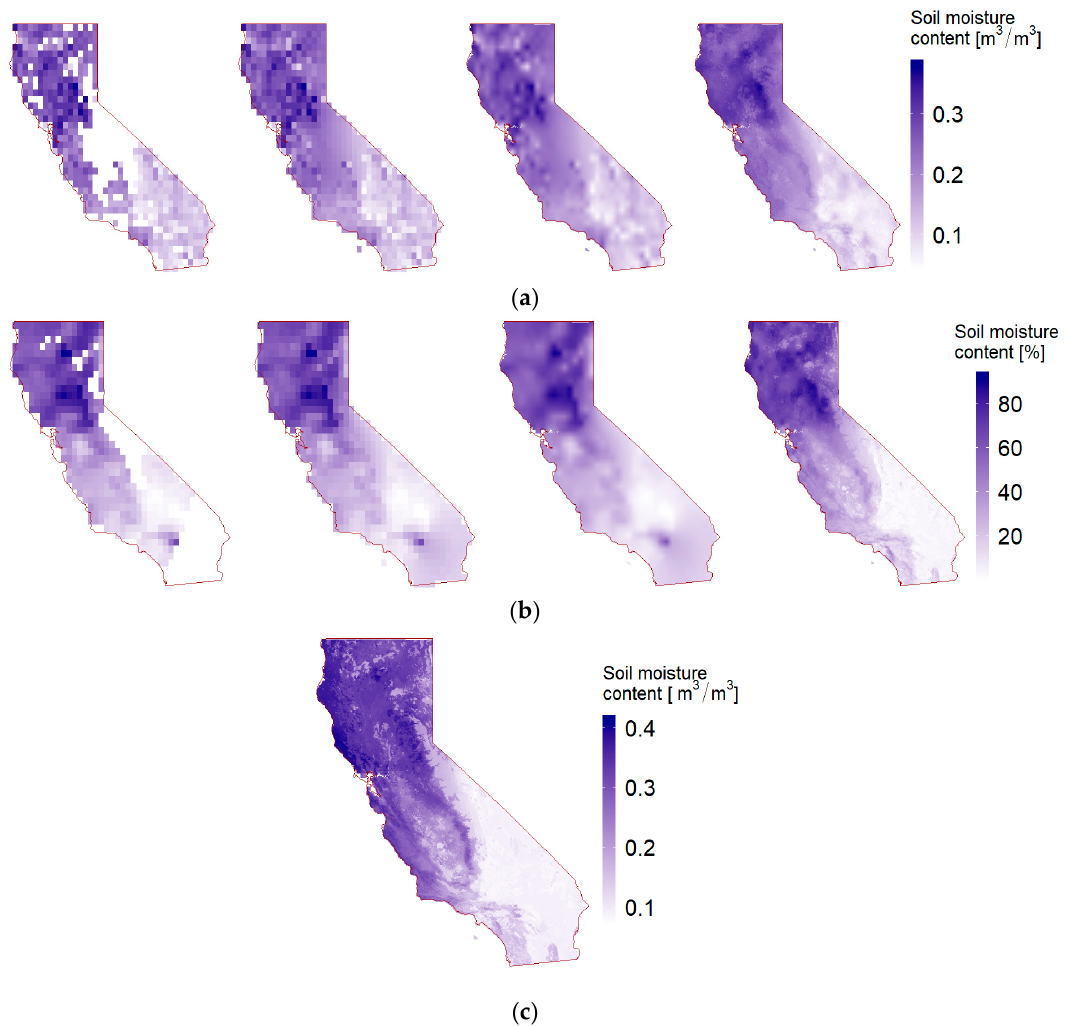
Figure 7. Output products after each processing step for DOY 81 2016: (a) combined ESA CCI SM input, daily filled, downscaled by bilinear interpolation (BIL) (Data engineering) and by RF products; (b) active ESA CCI SM input, daily filled, downscaled by BIL and by RF; and (c) final output SSM product.